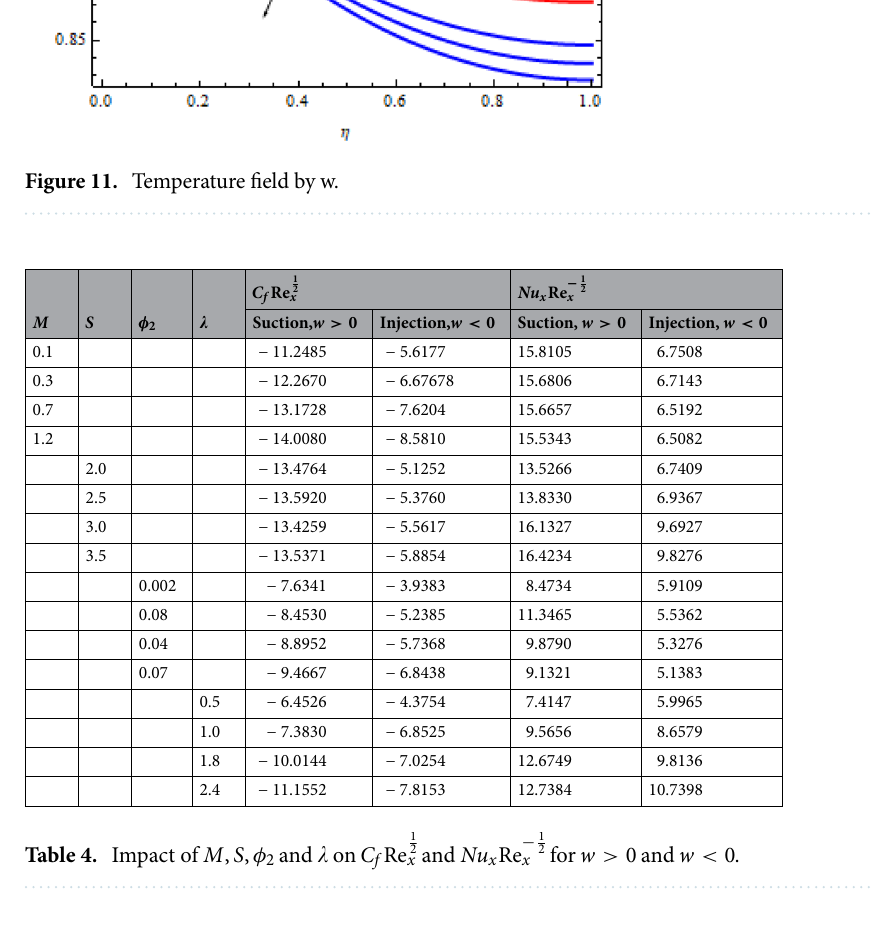
Table 4. Impact of M , S , φ 2 and (cid:31) on C f Re